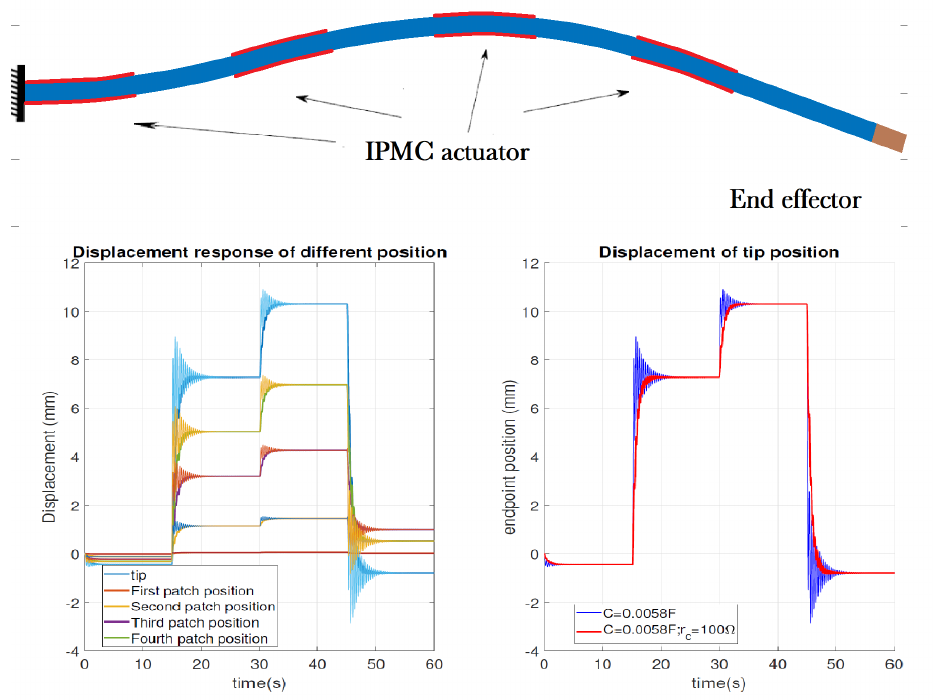
Figure 10. Desired configuration of the endoscope (control